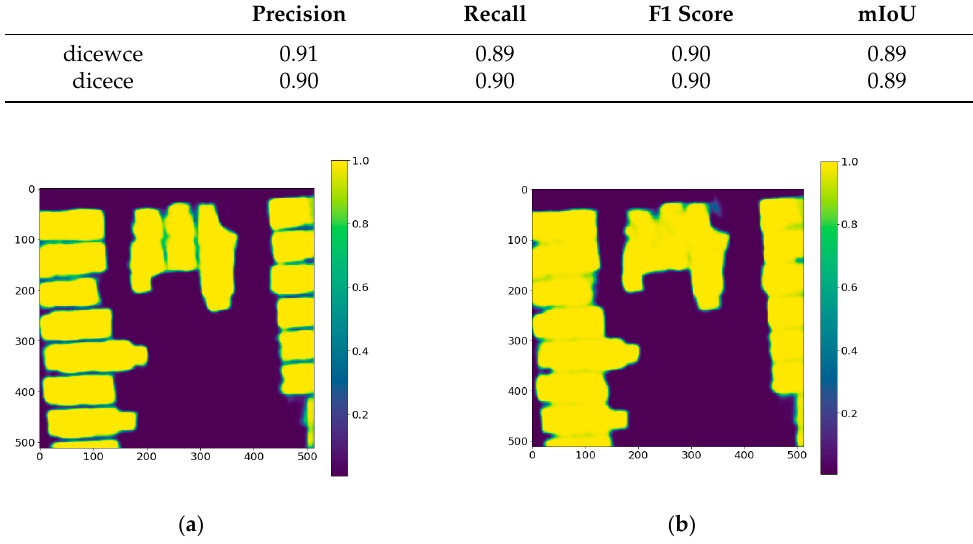
Figure 4. Example of probability maps generated by ( a ) the DeepLabv3+ model using dicewce loss function; ( b ) the DeepLabv3+ model using dicece loss function.